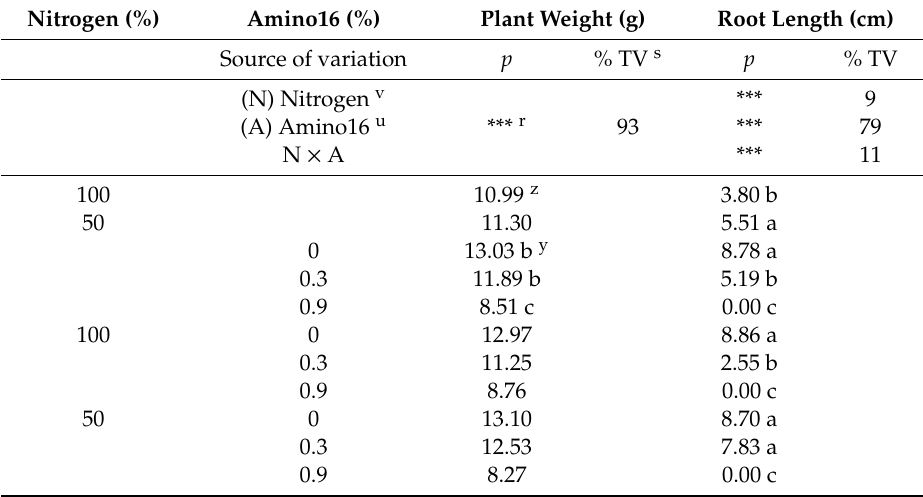
Table 4. Analysis of variance and mean comparison of plant weight and root length of red baby lettuce grown in 131 (100%) or 65.5 mg / L (50%) N supplemented with 0, 0.3, or 0.9% Amino16 ®